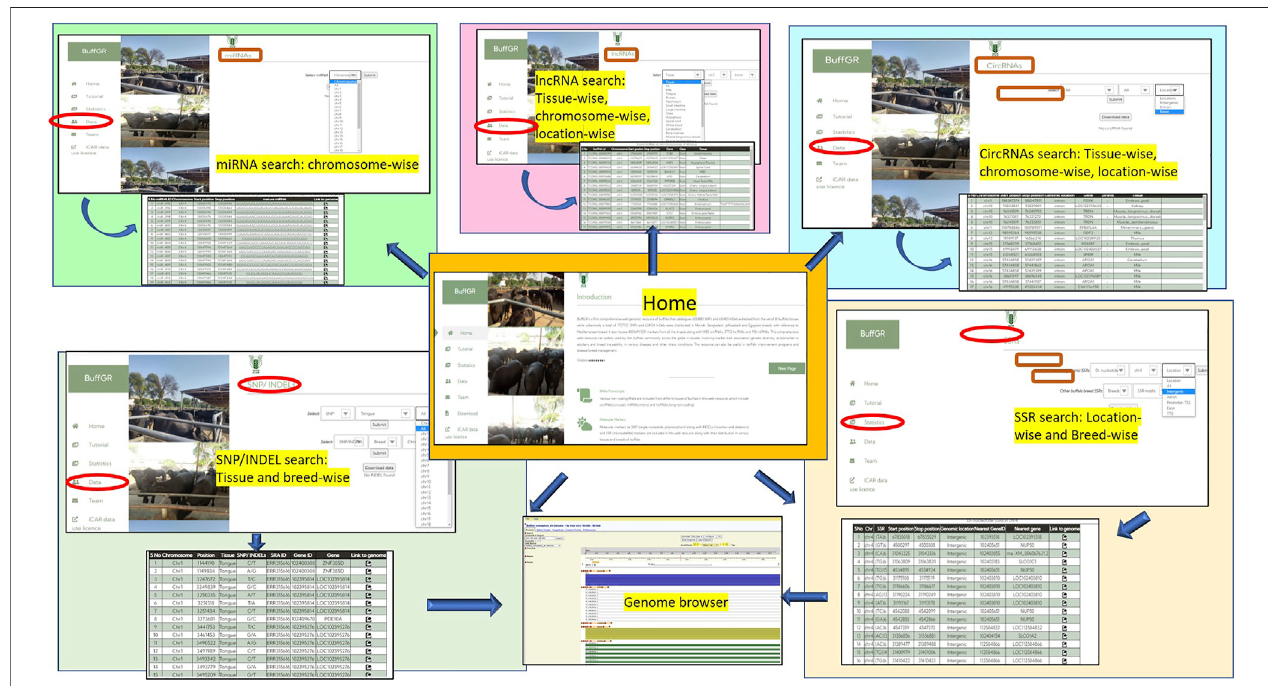
FIGURE 5 | Web interface of